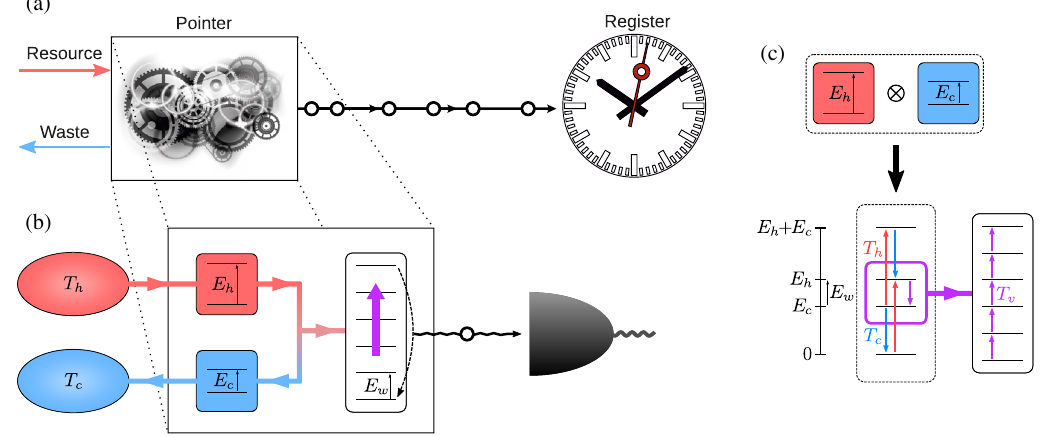
FIG. 1. (a) A pointer system generates a time-ordered sequence of events that are recorded and displayed by the register. (b) We consider a pointer comprising a two-qubit heat engine that drives a thermally isolated load up a ladder, whose highest-energy state undergoes radiative decay back to the ground state. Photons are thus repeatedly emitted and registered by a photodetector as ticks of the clock. (c) Avirtual qubit is a pair of states in the engine ’ s two-qubit Hilbert space whose energy splitting is resonant with the ladder. The thermal baths drive population into the virtual qubit ’ s higher-energy state and out of its lower-energy one, creating a population inversion described by a negative virtual temperature. Hence, placing the virtual qubit in thermal contact with the ladder forces the load upwards, thereby performing